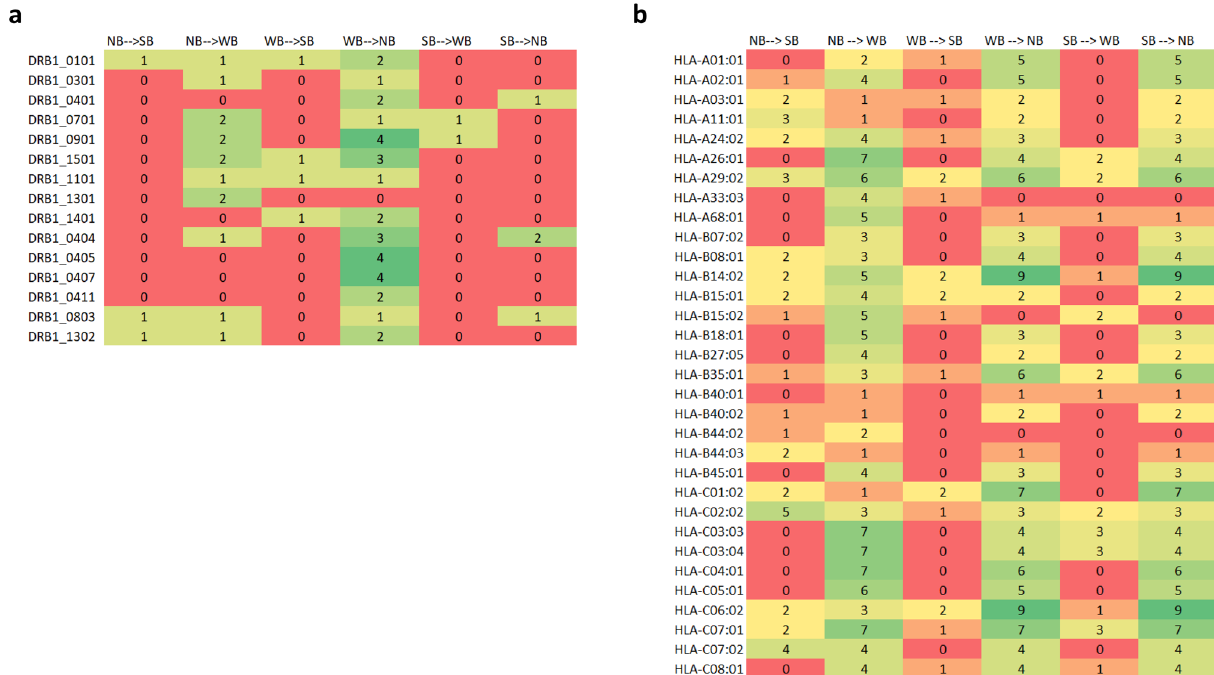
Fig. 2 In silico prediction and comparison of strong-, weak- and no-binding peptides derived from the ancestral Wuhan and B.1.1.529 Spike proteins. a The X -axis indicates the potential conversions of non-binding (NB), weak binding (WB) or strong binding (SB) 9-mer peptides and the Y -axis indicates the most common DRB1 alleles in the European-Caucasian population. b Corresponding analysis to ( a ) highlighting the most common HLA-I alleles in the European-Caucasian population on the Y -axis. The numbers and the color code indicate the number of 9-mer peptides with predicted in silico conversions in B.1.1.529 compared to the ancestral Wuhan strain for the respective HLA allotype. Red: low conversion rate; Green: high conversion